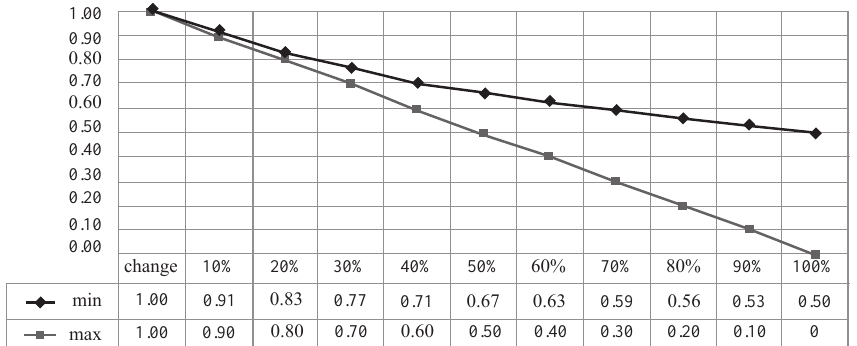
Fig. 1. Example for the unintentional weighting between minimisation and maximisation according to formula (4)